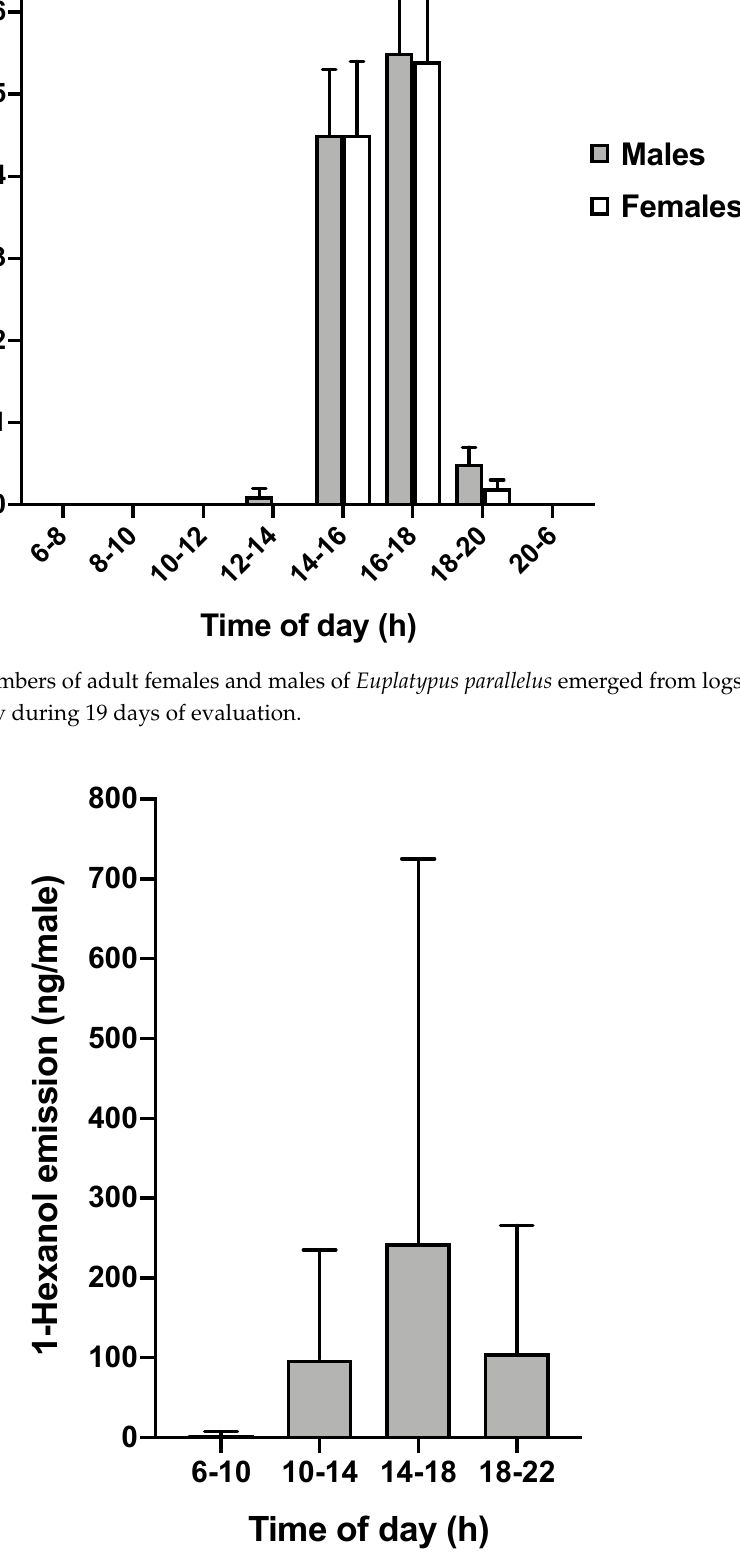
Figure 3. Mean ( ± SD) amount of 1-hexanol emitted per male of Euplatypus parallelus in every 4-h interval from 06:00–22:00 h.